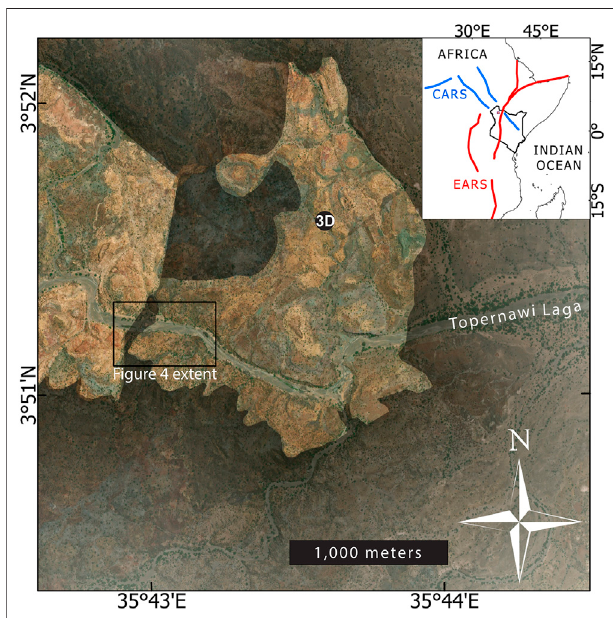
FIGURE 1 | Satellite imagery of the study area. Boundary of the Topernawi Formation is delineated by gray shading. Label “ 3D ” shows location of the fi eld photo in Figure 3D . Box outlined in thin black line shows extent of Figure 4 . Inset map shows outline of Africa (thin black line), Kenya(thickblackline),andgeneralizedstructureoftheEARS(red)andCARS (blue)after(Macgregor,2015).Extentofmainframeisshownasverysmallbox on inset